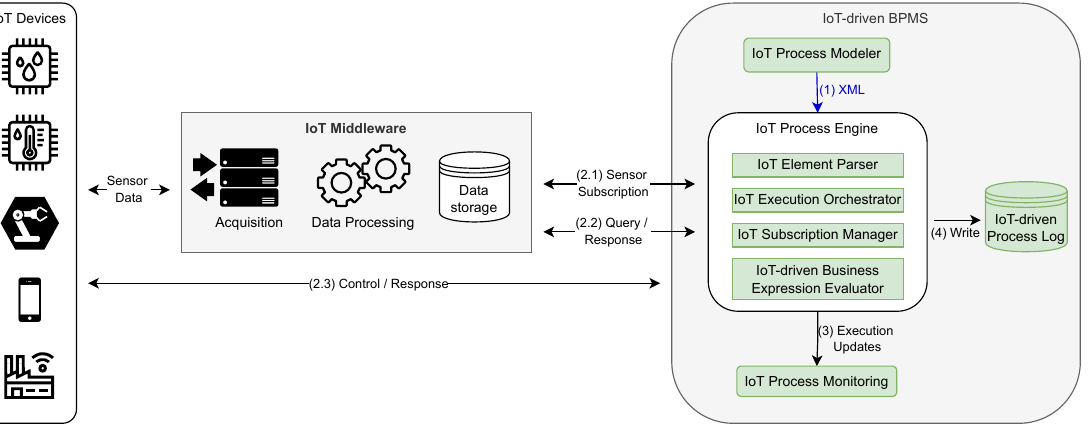
Figure 12. Abstract view on System architecture and communication between system